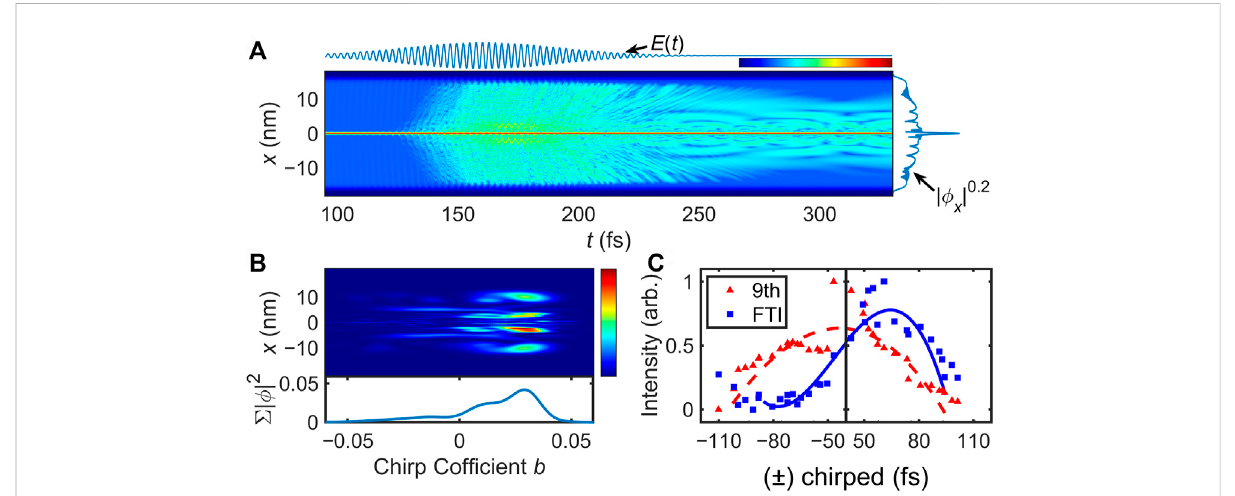
FIGURE 4 (A) Temporal population evolution of a krypton atom exposed to external laser fi elds in the strong- fi eld tunnelling regime. The top curve is the time domain shape of the laser electric fi eld, and the curve on the right is the populations of krypton when driving laser is off. (B) One-dimensional populations of excited states surviving in different chirped intense laser fi eld. The horizontal axis of the coordinate is the chirp coef fi cient b in Eq. 1. The curve below shows the integral of populations under different chirp coef fi cient b . (C) Chirp dependence of the harmonic near threshold (9th, red triangle) and the FTI emission (blue square) observed in experiments. The abscissa is the pulse duration of driven laser which represent different